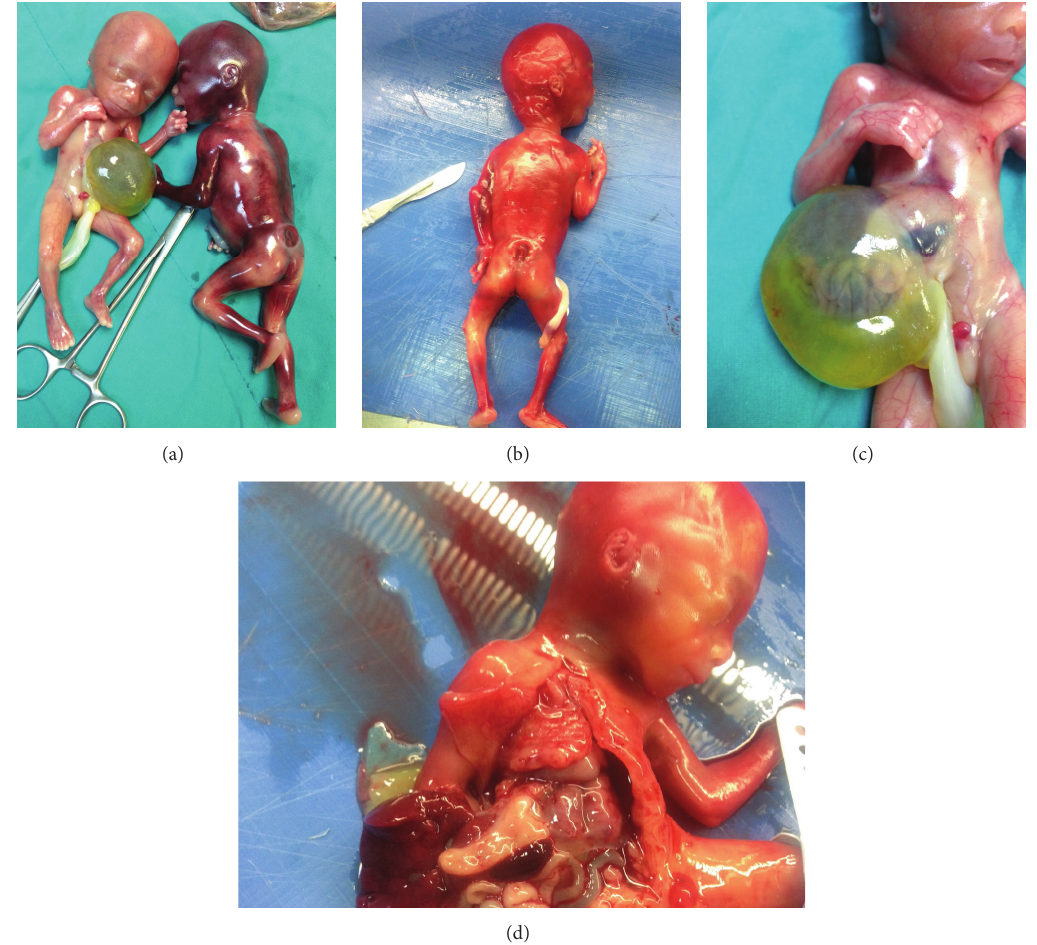
Figure 2: Postabortal appearance of both fetuses. (a) The omphalocele sac. (b) The lumbosacral meningomyelocele. (c) The bifid sternum. (d) The absence of